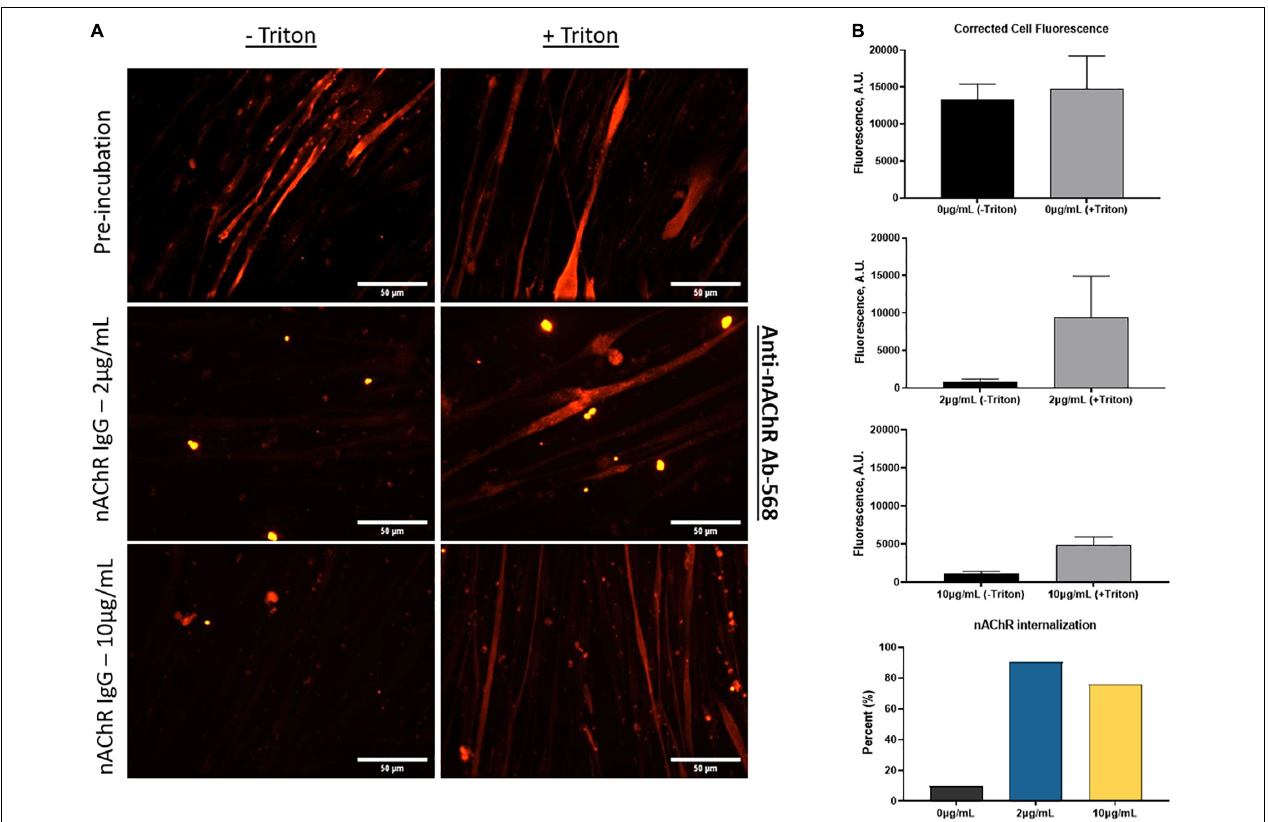
FIGURE 4 | Anti-nAChR Abs induce receptor internalization. (A) ICC images of SKM stained for anti-nAChR Ab with and without triton (top panel), incubated with 2 µ g/mL or 10 µ g/mL anti-nAChR Ab, middle and bottom panels, respectively, and later fixed and blocked with and without triton. Scale bars = 50 microns. (B) The corrected total cell fluorescence between the surface receptors (black bars) and internalized receptors (gray bars) for each condition. The percent change in fluorescence is represented as a bar graph for nAChR